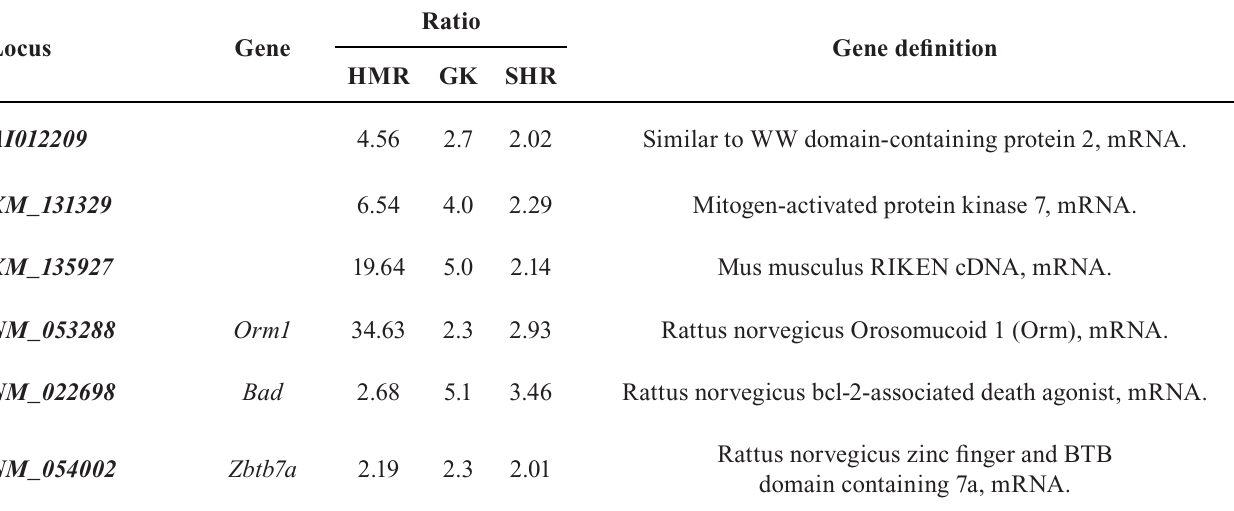
TABLE II - Genes upregulated in hyperlipidemia, diabetes and hypertension groups Locus